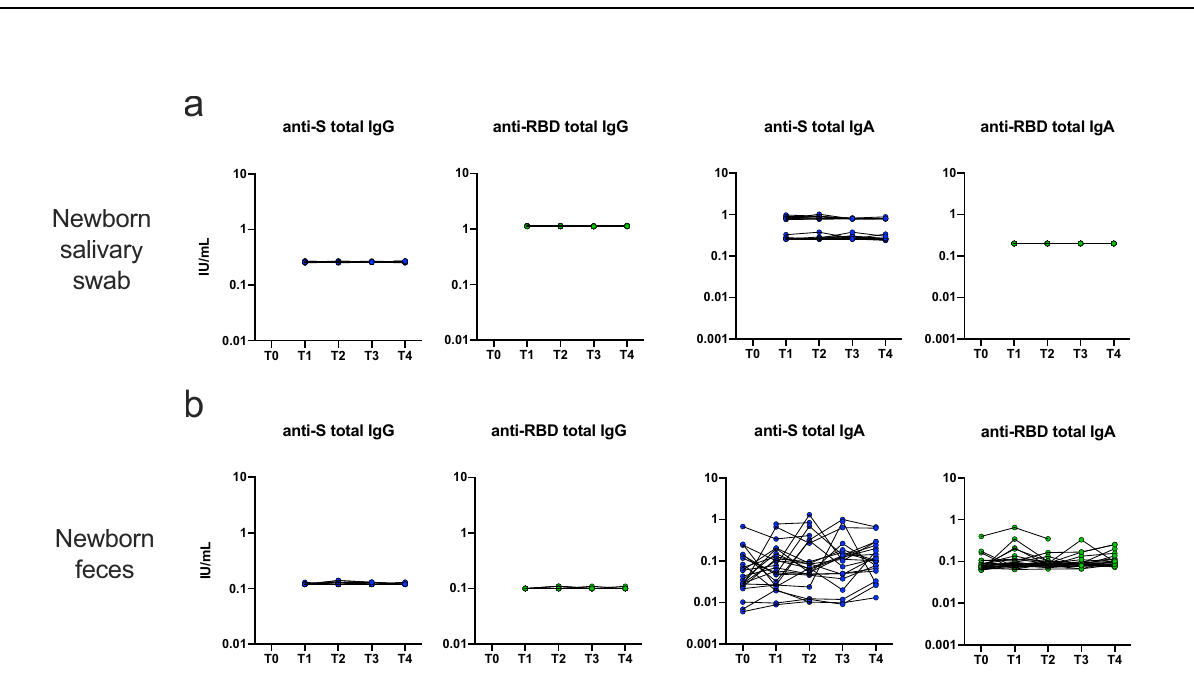
Fig. 3 Antibody concentrations in neonatal mucosal samples up to 90 days after vaccination. a , b Antibody concentrations at different timepoints in neonatal samples, after maternal vaccination with BNT162b2 vaccine ( n = 23). If there were no missing samples, P values were calculated by repeated-measures ANOVA with Dunnett ’ s correction for multiple comparison. In case of randomly missing samples, a mixed- effect model using the maximum likelihood method was